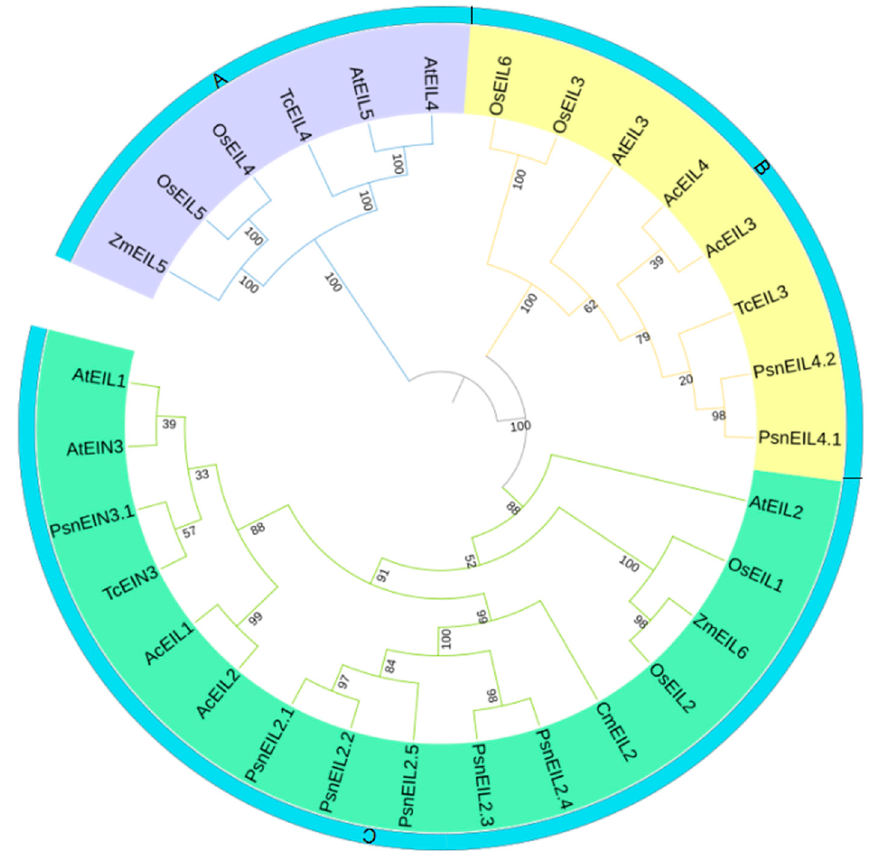
Figure 3. Phylogenetic relationships of EIN3/EIL genes of Populus × xiaohei and other species. The phylogenetic tree was generated from the alignment of 30 EIN3/EIL protein homeodomain sequences with 1000 bootstrap replicates. EIN3/EIL members are distributed in three main clades, namely clades A, B, and C marked in green, blue, and yellow, respectively. Bootstrap values are shown near the nodes. (At: Arabidopsis thaliana [ AtEIN3 (NP_188713.1), AtEIL1 (NP_180273.1),